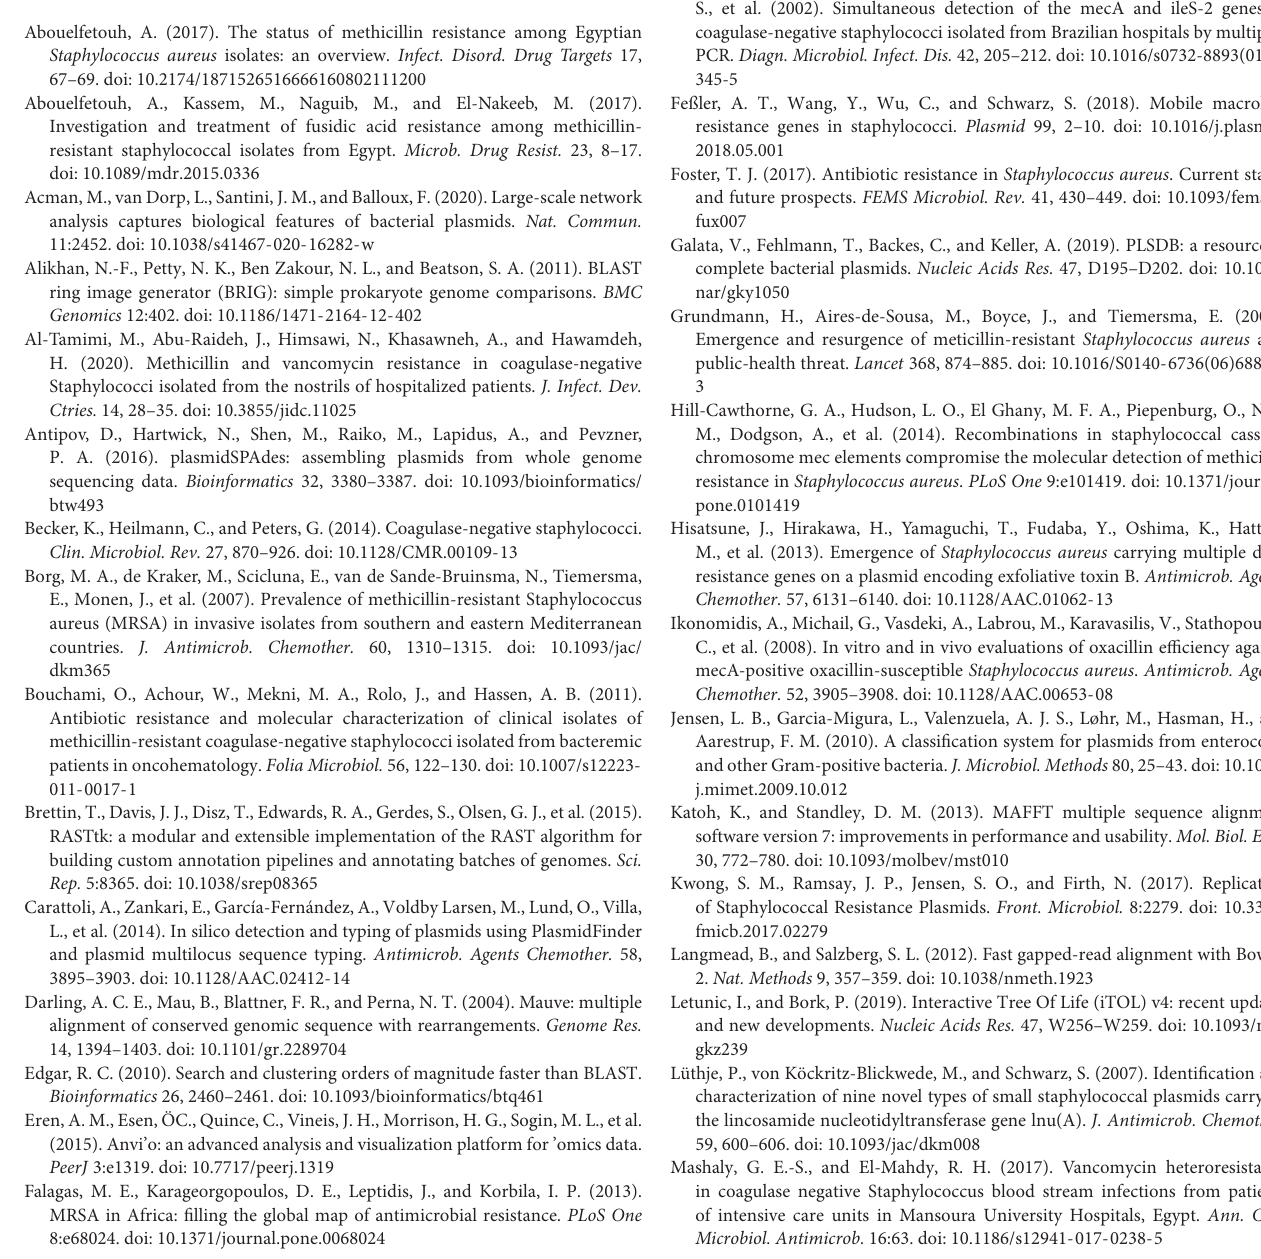
Supplementary Table 1 | Plasmid vs. genome sequence coverage.